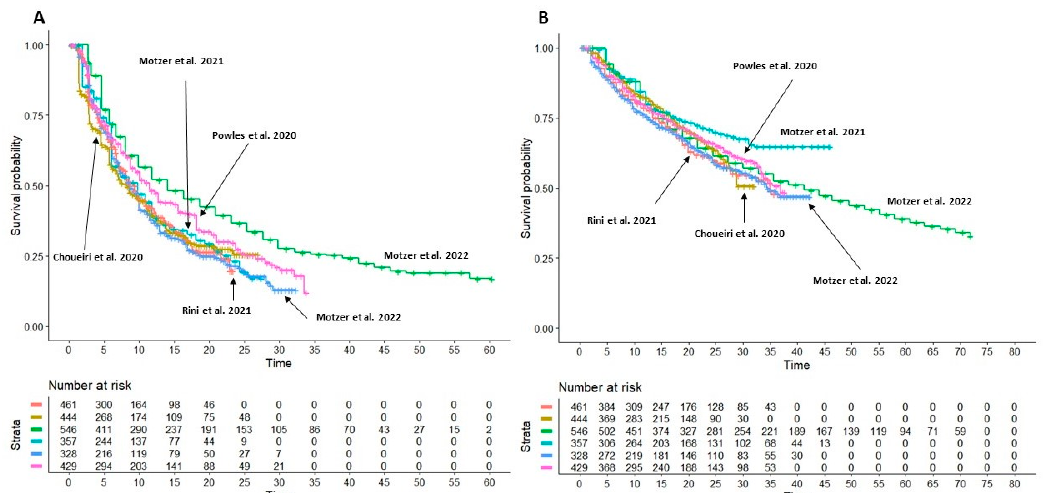
Figure 3. After reconstruction of individual patient data from control arms of included trials (sunitinib monotherapy 50 mg), the following Kaplan-Meier curves were generated from: Rini et al., 2021 ( n = 461; in red [11]); Choueiri et al., 2020 ( n = 444; in gold [12]); Motzer et al., 2022 ( n = 546; in green [13]); Motzer et al., 2021 ( n = 357; in light blue [14]); Motzer et al., 2022 ( n = 328; in blue [15]); Powles et al., 2020 ( n = 355; in purple [16]). ( A ) progression-free survival (PFS), ( B ) Overall survival (OS). Time in months.